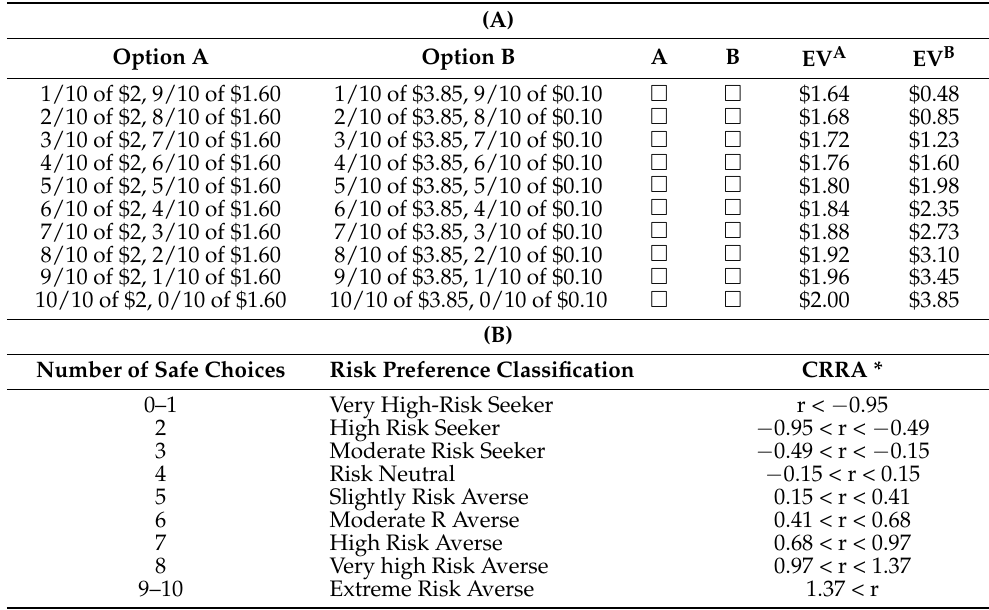
Table 4. ( A ): Holt and Laury (2002) method of risk attitude. ( B ): Holt and Laury (2002) method of classification of risk